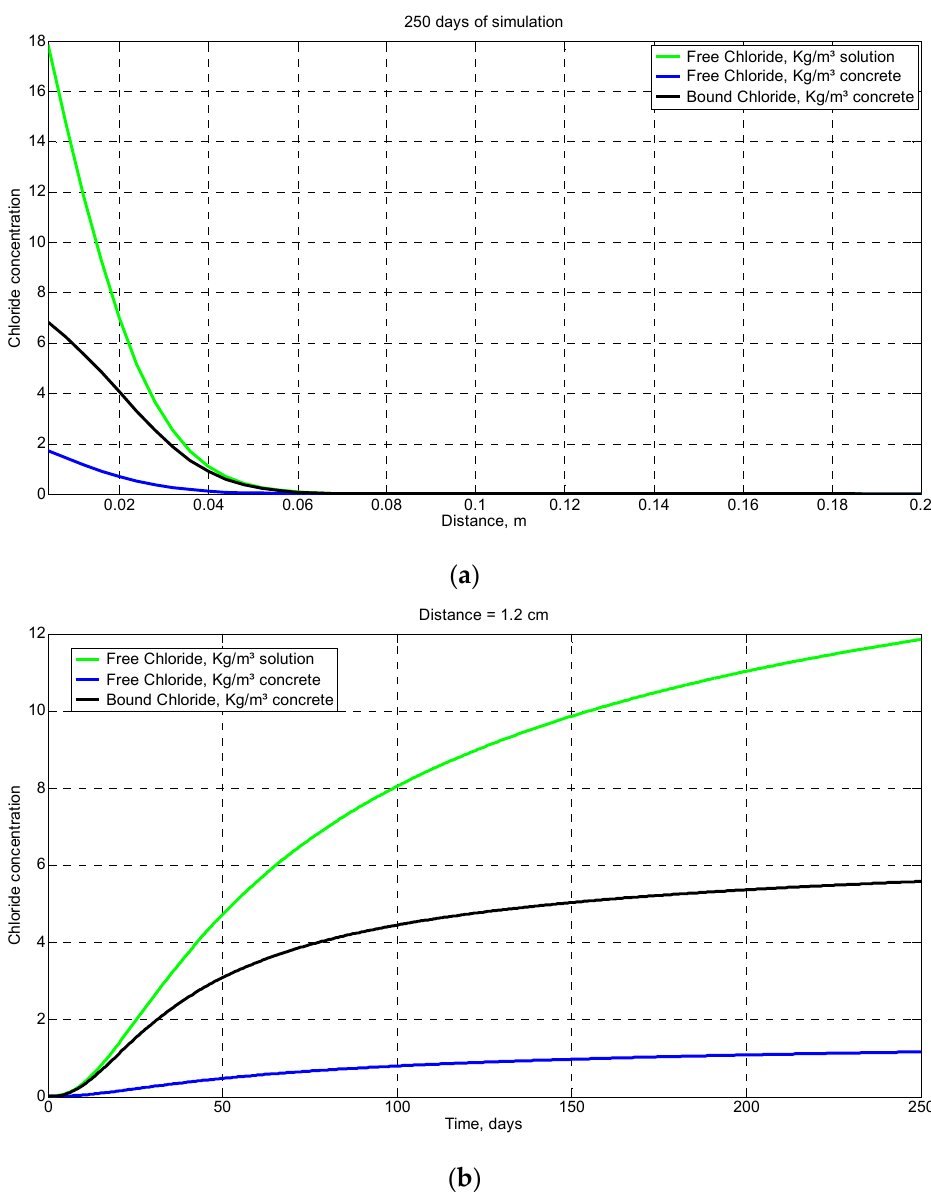
Figure 15. ( a ) Spatial concentration of three species of chloride, C f,s (free chloride in kg/m 3 solution), C f,c (free chloride in kg/m 3 concrete) and C b (bound chloride in kg/m 3 solution), after 250 days. ( b ) Time dependence of concentration of three species of chloride at x = 1.2 cm